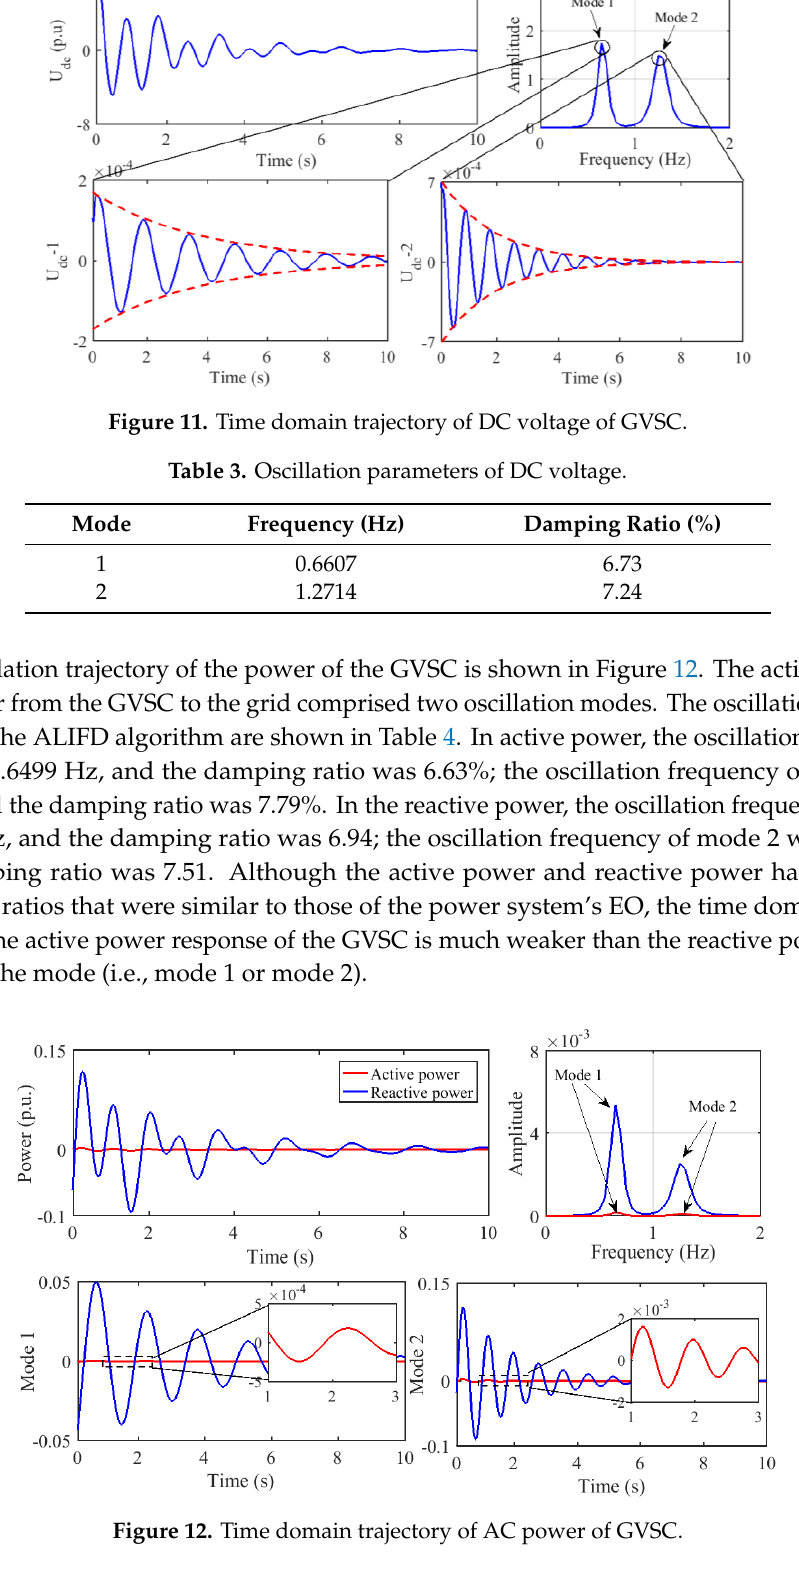
Figure 12. Time domain trajectory of AC power of GVSC.